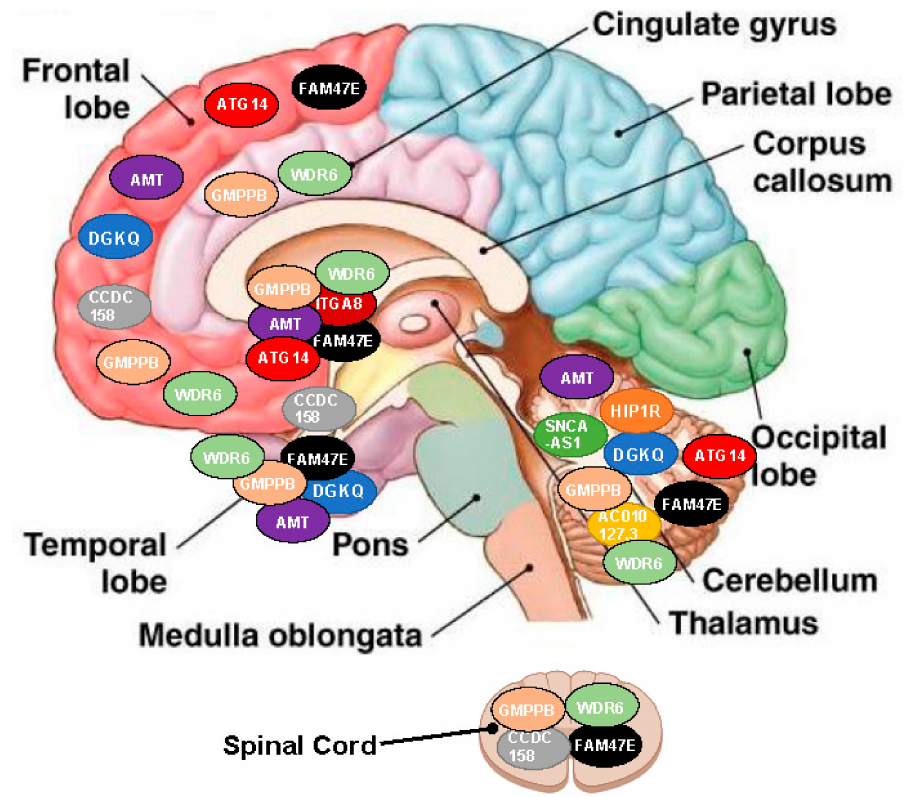
Figure 1. Map of the genes influenced by the SNPs (based on linkage disequilibrium analysis and